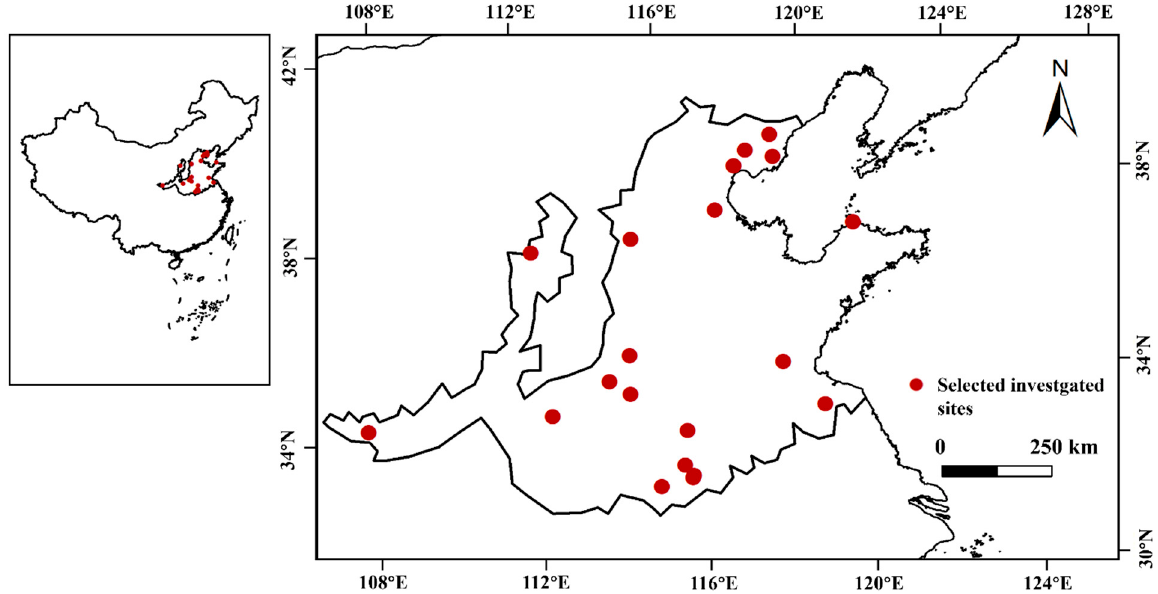
Figure 1. Location of the Huang-Huai-Hai farming region and 19 investigated sites. The investigated sites were in Leting, Lutai, Guanzhuang, Lulong, Gaocheng, Hua County, Xincai, Yuanyang, Xiangfu, Yichuan, Penglai, Hedong, Taihe, Yingquan, Yingzhou, Qiaocheng, Mei County, Guannan and Ninghe.